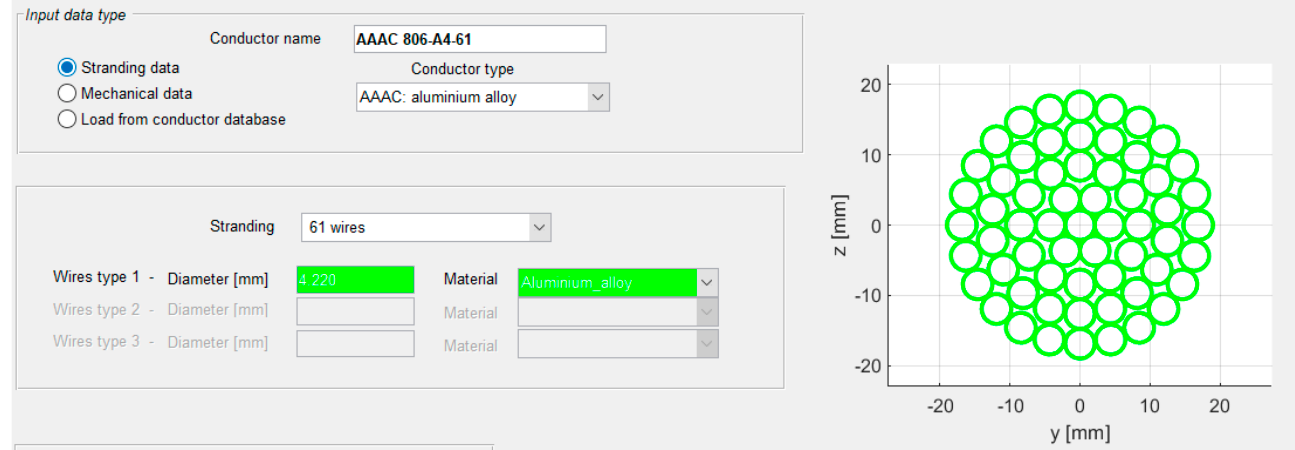
Figure 21. Conductor modelling in ATTRA software.